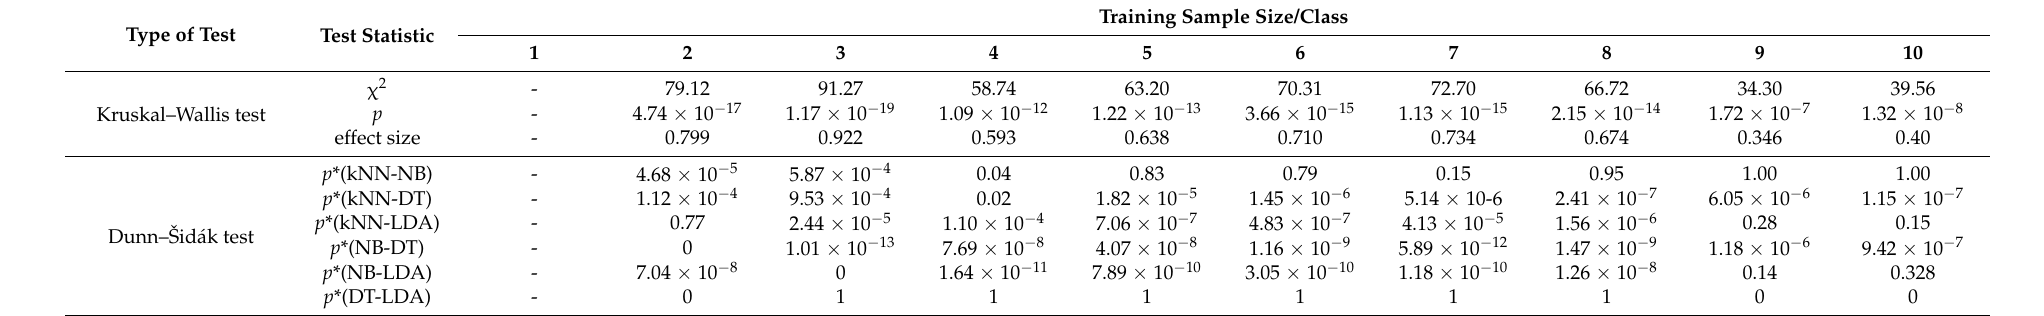
Table A5. Result of Kruskal–Wallis test and Dunn–Šidak tests for comparison of algorithms (kNN-k-nearest neighbor, NB-naïve Bayes, DT-decision tree, LDA-linear discriminant